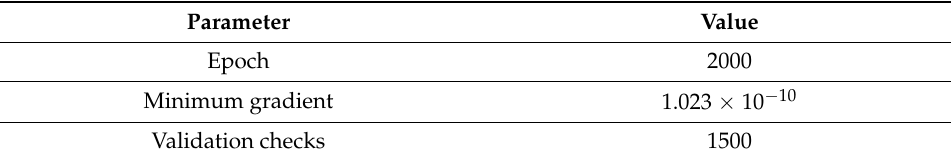
Table 4. ANN training parameters.